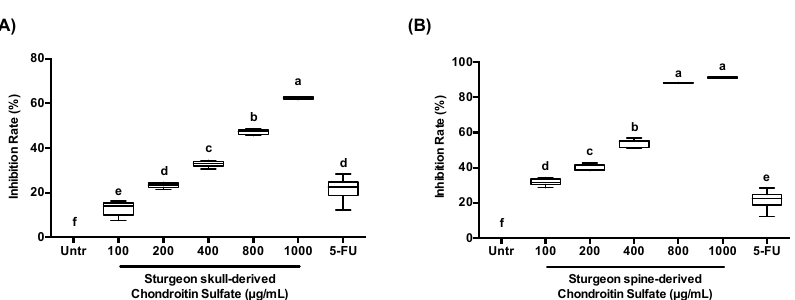
Figure 1. Effect of chondroitin sulfate (SCS) on cell proliferation in colon cancer HCT-116 cells. Colon cancer HCT-116 cells were treated with different concentration (100, 200, 400, 800, and 1000 μ g/mL) of SCS and 5-fluorouracil (5-FU; 100 μ g/mL) for 24 h. Cell viability was measured by CCK8 cell counting assay and the results were expressed as inhibition rate (%) compared to untreated cells. ( A ) SCS extracted from sturgeon skull, ( B ) SCS extracted from sturgeon spine. All results are expressed as mean ± SEM ( n = 3). Different superscript letters for each column indicate significant differences ( p < 0.05) as compared to every other group. 3.2. Sturgeon-Derived Chondroitin Sulfate (SCS) Induces Cell Cycle Arrest of HCT-116 Cell proliferation is correlated with the regulation of cell cycle progression. Therefore, we determined the effects of SCS on cell cycle arrest on HCT-116 cells. SCS treatment significantly regulated the cell cycle arrest of HCT-116 and therefore affected cell proliferation (Figure 2). SCS treatment increased the accumulation of cell population in the G0/G1 phase from ~40% in untreated cells to ~90% after treated with highest concentration (400 μ g/mL) of SCS. At the same time, the percentage of cells in the S phase was significantly decreased from ~40% in untreated cells to ~5% after treatment, and the G2/M phase was significantly decreased from ~20% to ~5%.